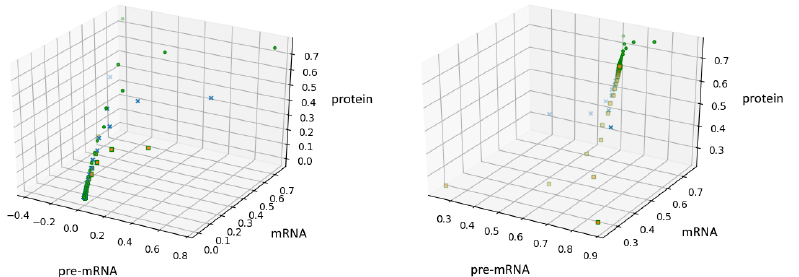
Figure 2. A solution of Equation (4) for δ = 1, R = 1, µ PR = 1 on the left and i = 1 on the